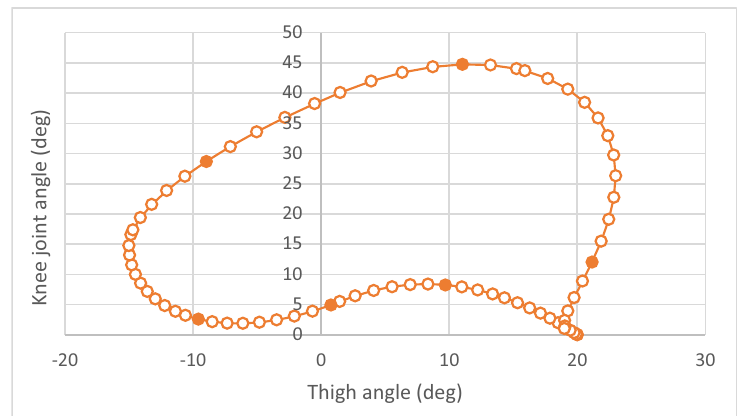
Figure 20: Analyzing gait by the cyclical process ( cyclogram ) . ( a ) Initial contact, ( b ) loading response, ( c ) mid - stance, ( d ) terminal stance, ( e ) pre - swing, ( f ) initial swing, ( g ) mid - swing, and ( h ) terminal